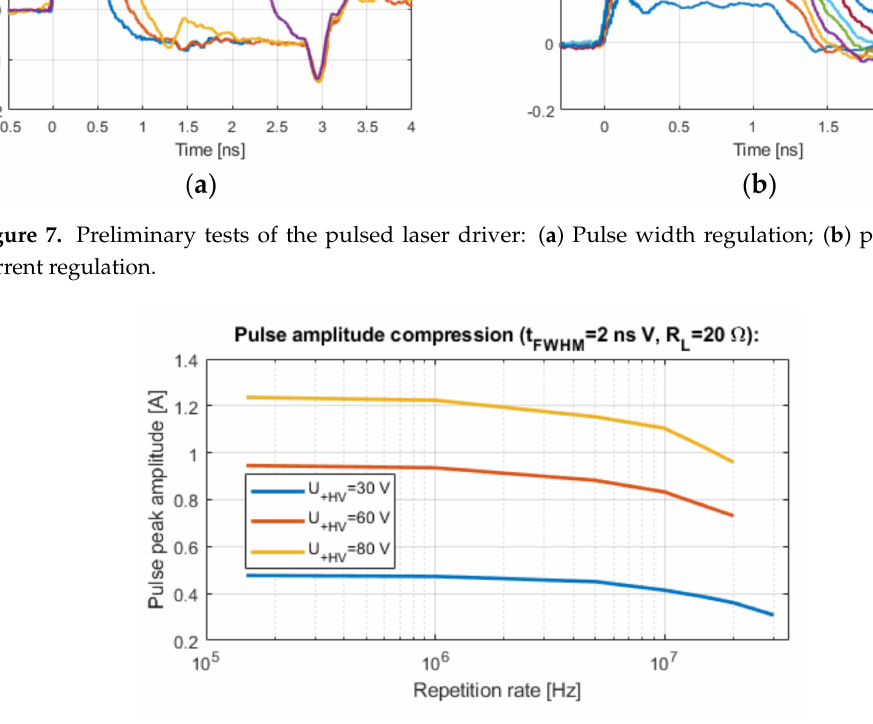
Figure 8. The pulse amplitude compression as a function of repetition rate.